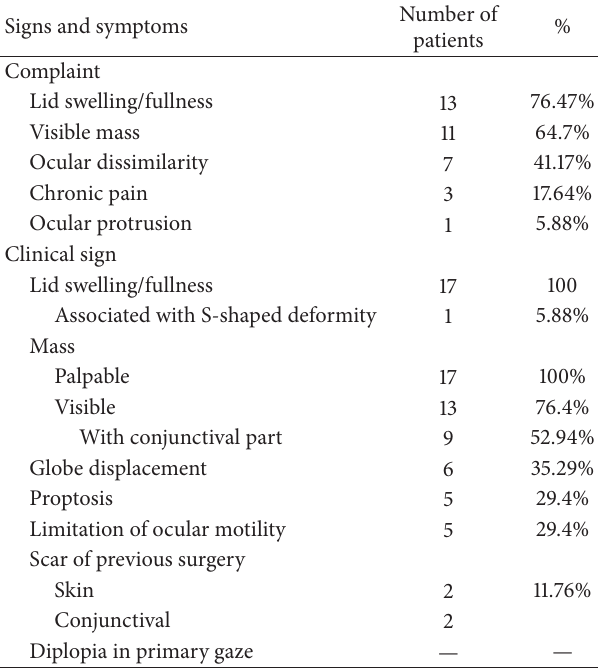
Table1:Frequencyofcomplaintsinpatients’ownwordsandclinical signs where a mass with lid swelling is detected in all